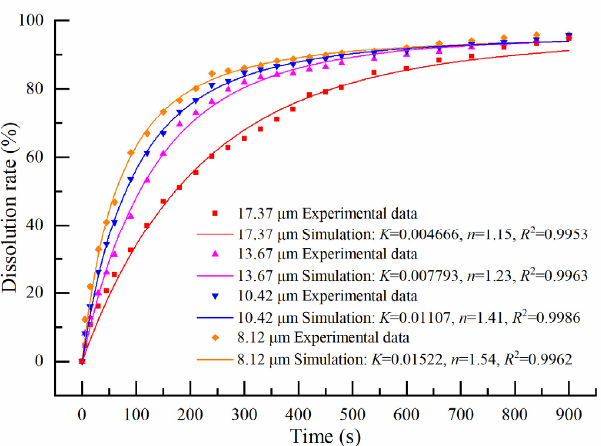
Figure 9. Effects of particle size on chloride ion dissolution rate with S/L ratio of 1:50 and stirring speed of 600 rpm at 25 °C.